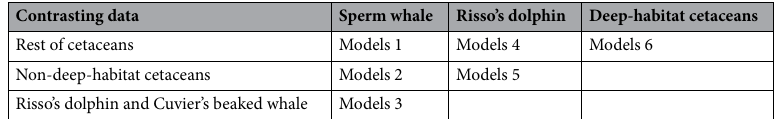
Table 3. Binary variables and models generated when the presence of species in the first row are contrasted with the presence of species in the first